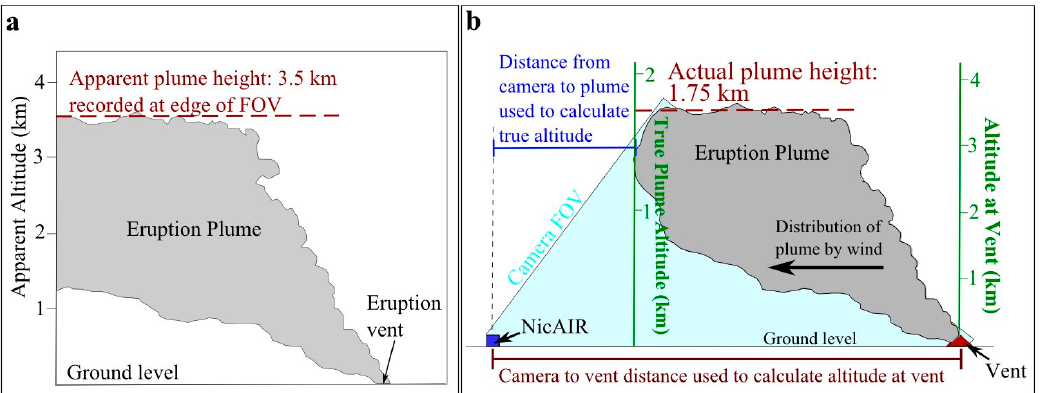
Figure 5. Actual cloud height derived from apparent cloud height and cloud location. ( a ) Schematic field of view from the perspective of the camera showing apparent plume height and ( b ) schematic side-view illustrating the effect of transport towards the camera on actual versus apparent plume height.